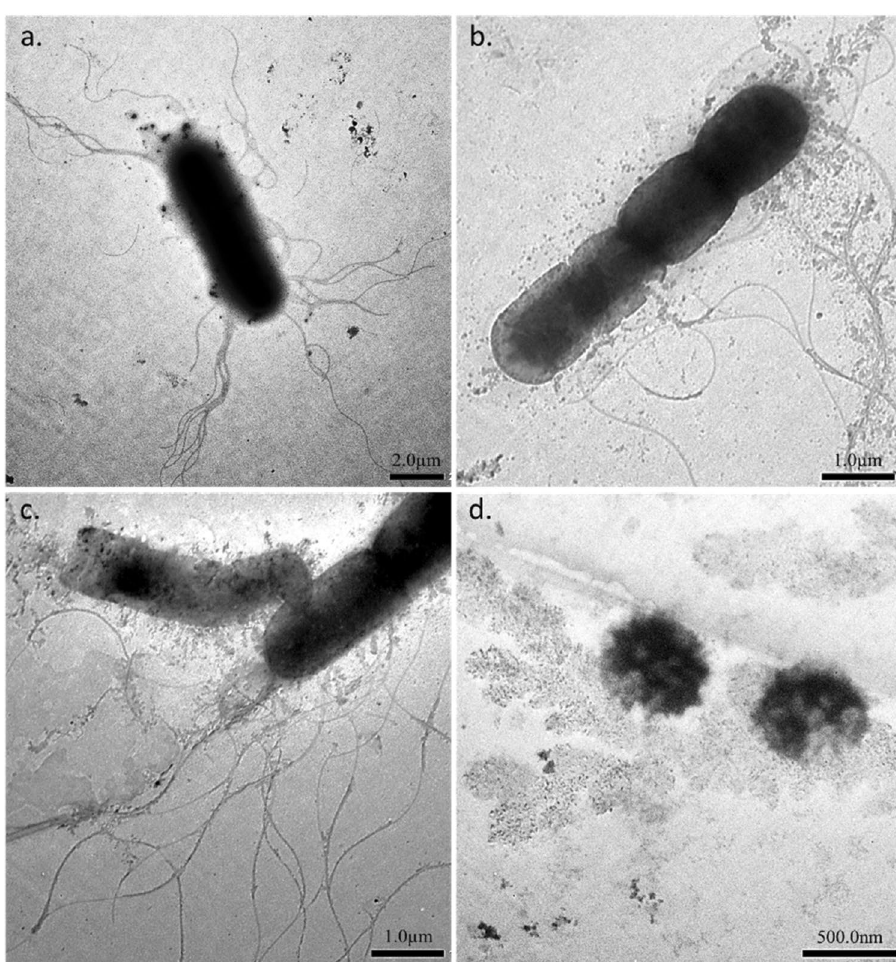
Figure 3. Transmission Electron micrographs showing mature vegetative cells with peritrichous flagellation ( a ); different stages of cell division ( b , c ); and free endospores ( d ) of BMCSI